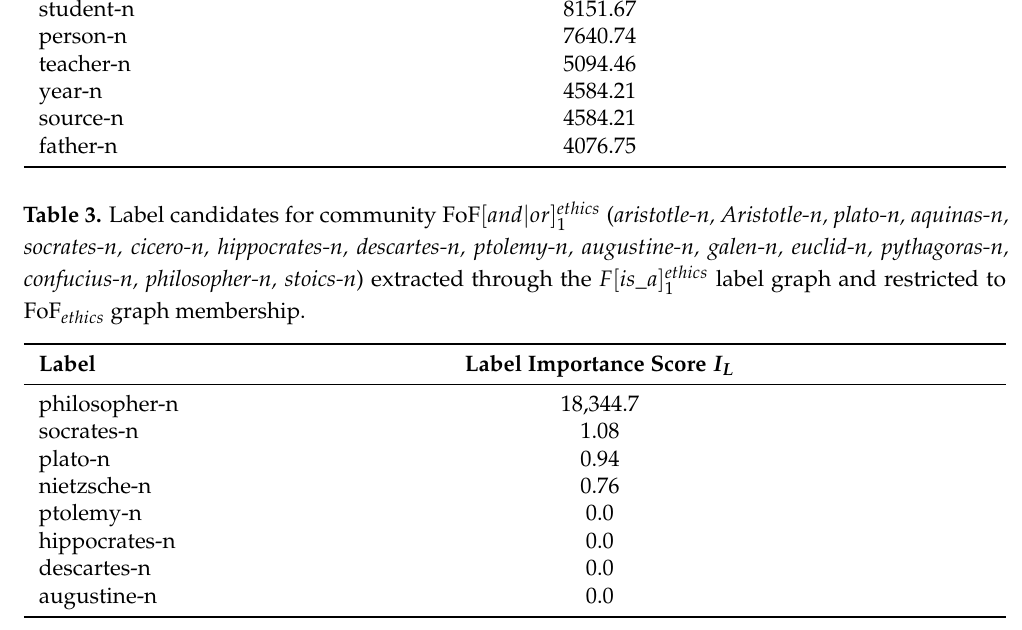
Label candidates for community FoF [ and | or ] love graph in non restrictive setting.